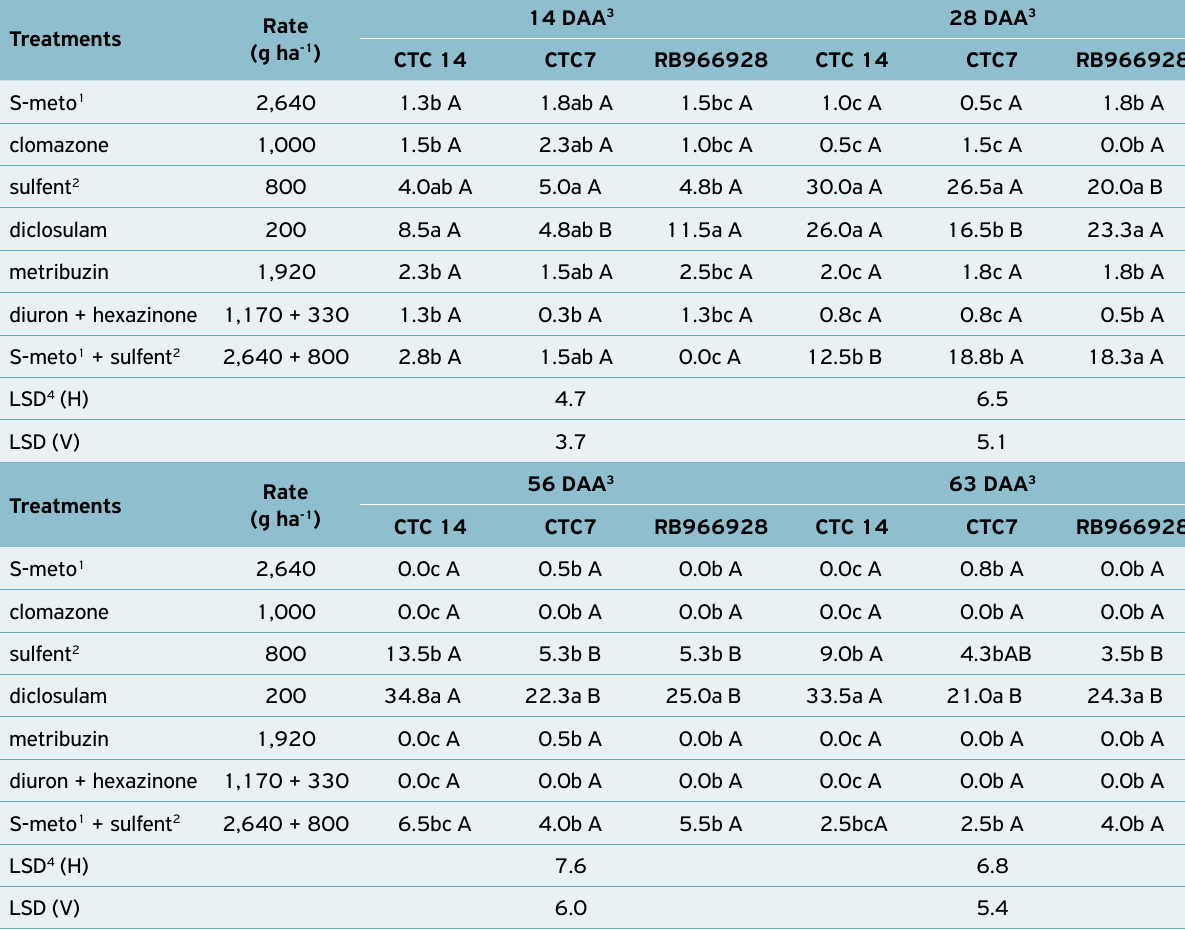
Table 2. Percent mean values of intoxication in the interaction between three sugar cane cultivars and different herbicides applied in pre-planting. Pradópolis, state of São Paulo, Brazil, 2013.